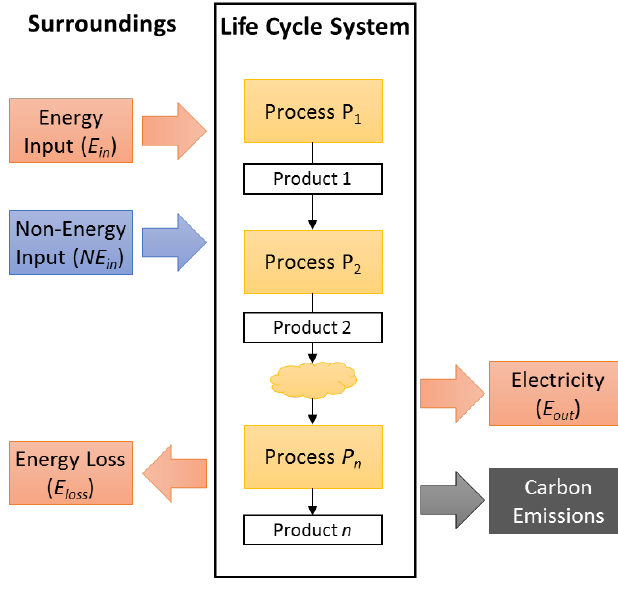
Figure 2. A generic representation of a multi-process life cycle system.